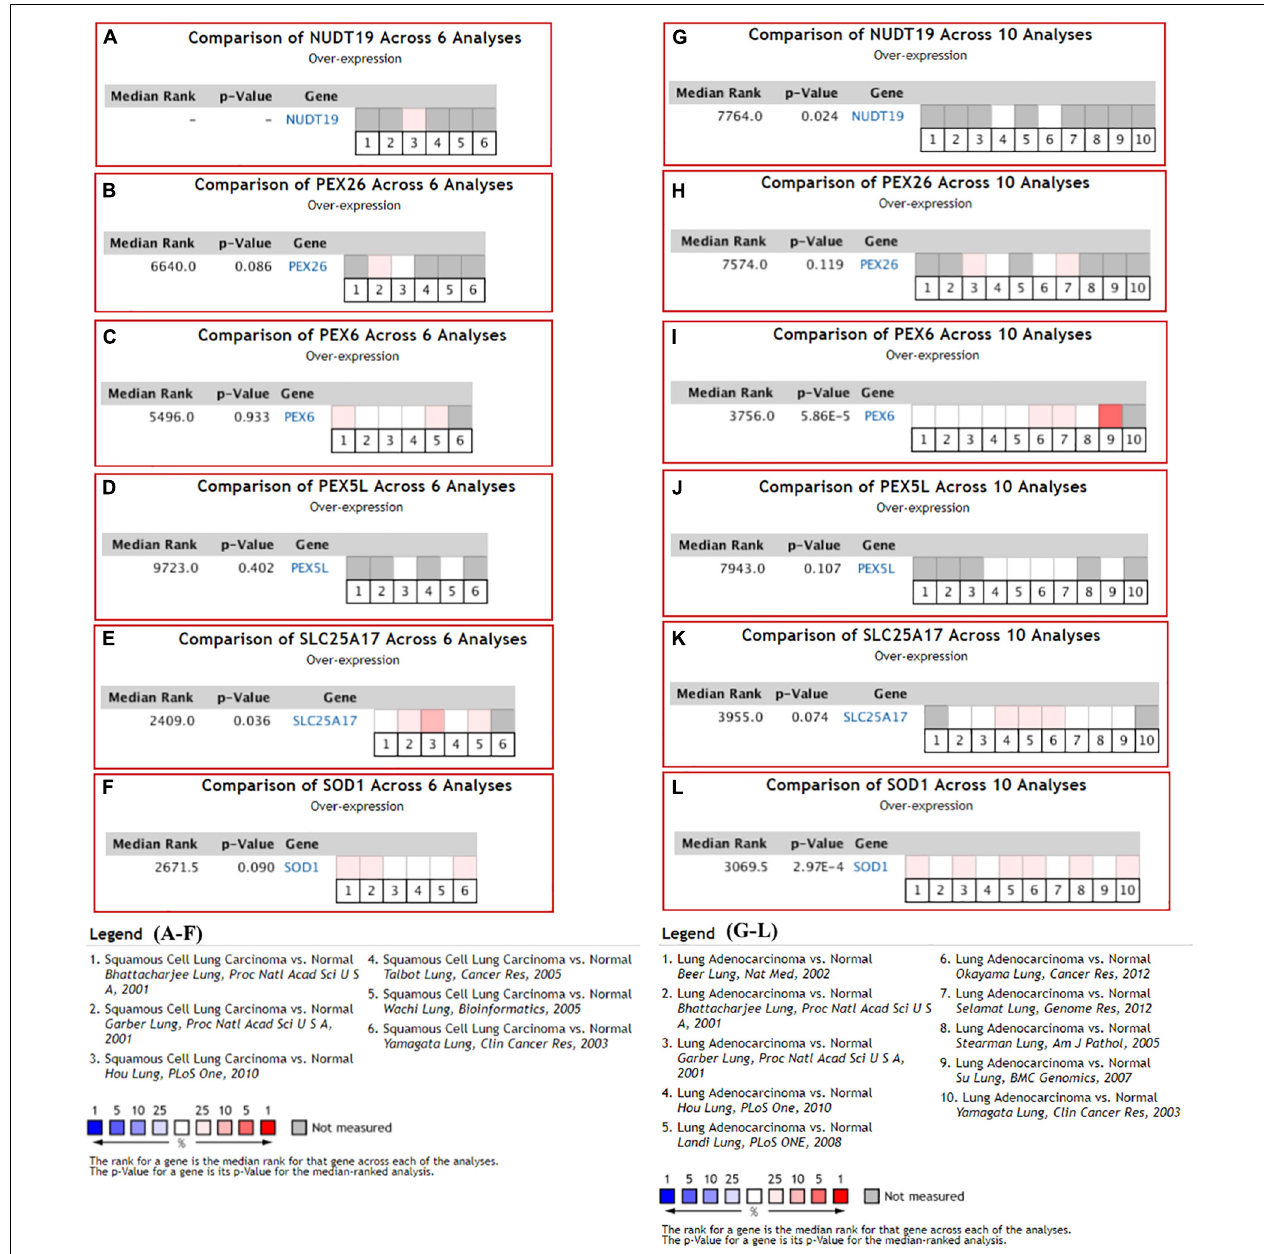
FIGURE 4 | Oncomine meta-analysis of the up-regulated Key C-DEPGs (K-DEPGs) in NSCLC. (A) NUDT19 data was available only in Hou lung in LUSC (fold change = 1.535, p < 0.01, Supplementary Table S1 ) and there was not enough data for its meta-analysis. (B–D,F) there was no significant expressional difference of PEX26, PEX6, PEX5L, and SOD1 in LUSC. (E) SLC25A17 was significantly up-regulated in LUSC. (G,I,L) NUDT19, PEX6, and SOD1 was significantly up-regulated in LUAD. (H,J) PEX26 and PEX5Lwas not significantly up-regulated in LUAD. (K) There was a trend of up-regulation of SLC25A17 in LUAD. NSCLC, non-small cell lung cancer; LUSC, lung squamous carcinoma; LUAD, lung adenocarcinoma; C-DEPGs, common differentially expressed peroxisome pathway genes. For all the analyses, p < 0.05 was considered significant.